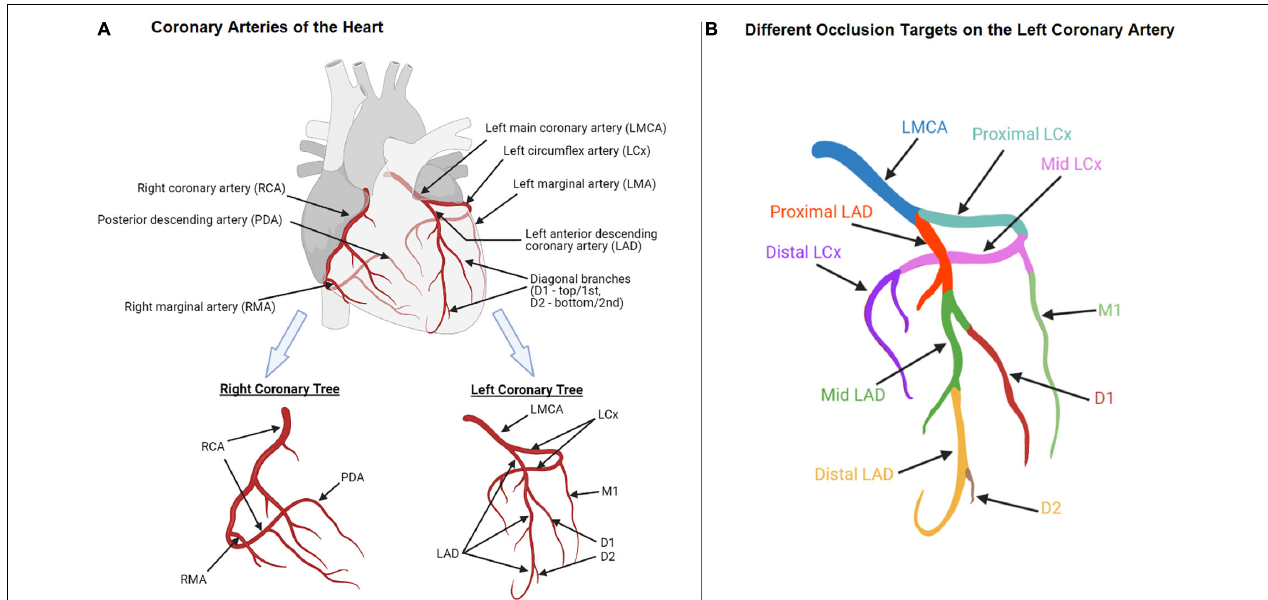
FIGURE 1 | Anatomy of coronary arteries of the heart (A) Left and right coronary trees; (B) Different occlusion targets (indicated in different colors) on the left coronary